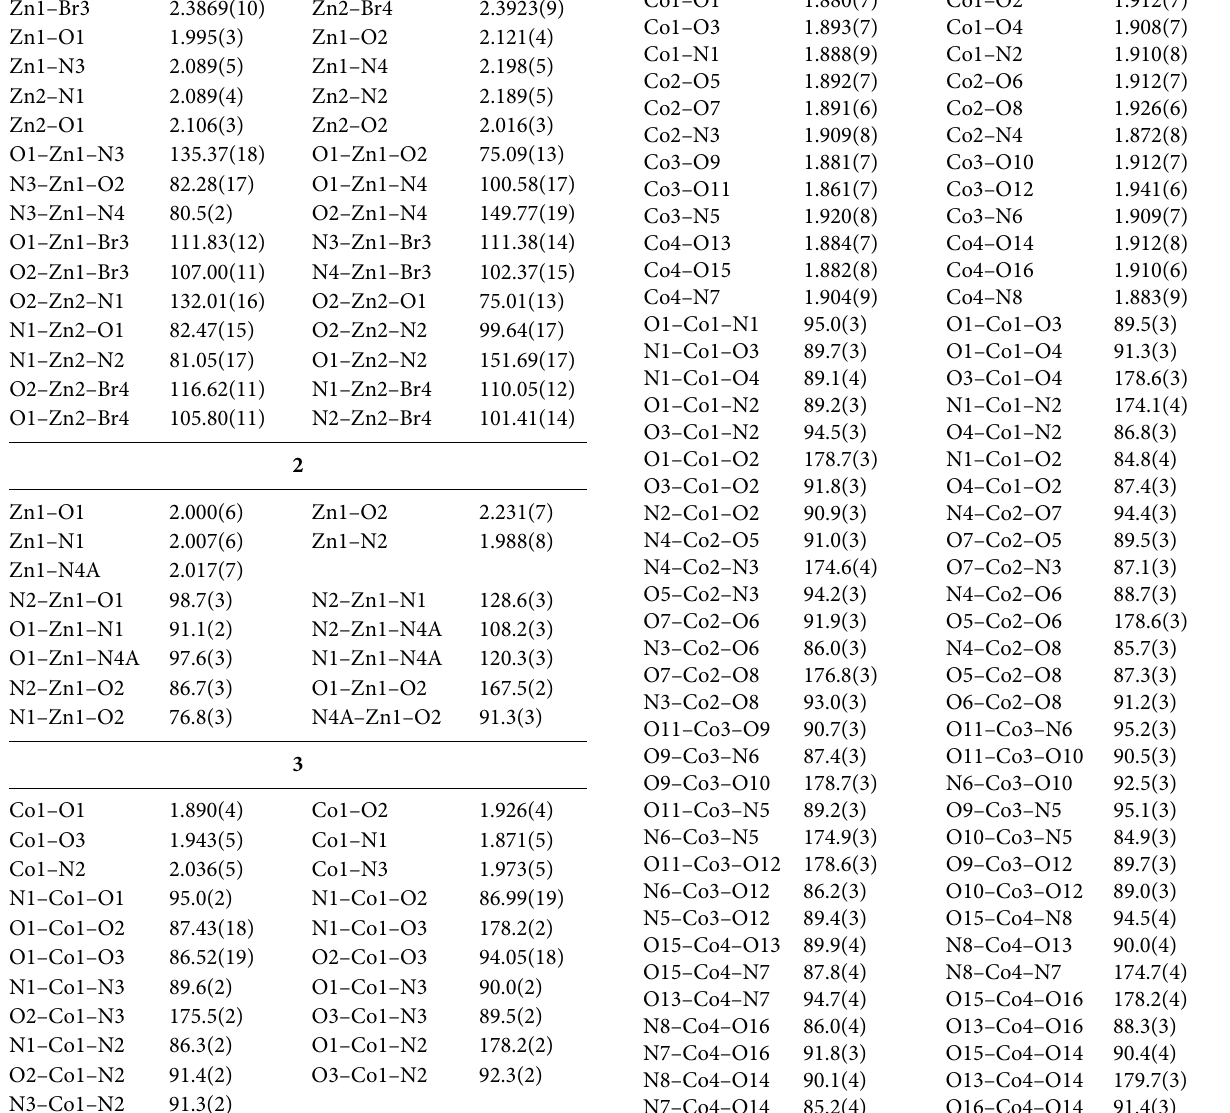
Symmetry code for A: –1 + x , y , z